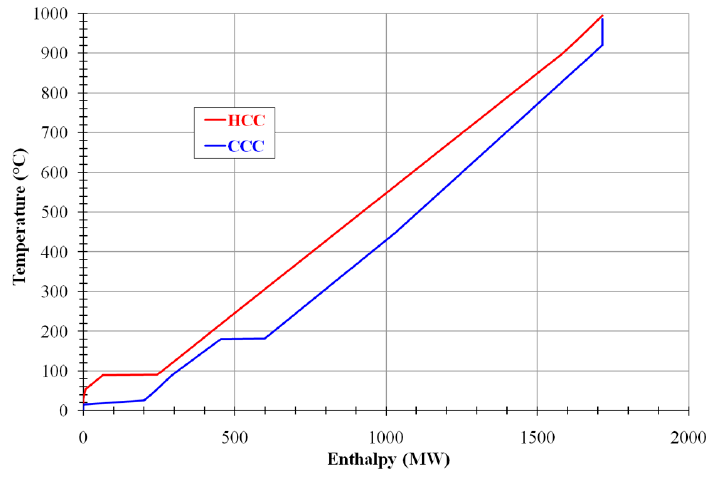
Figure 4. Hot and cold composite curves for CLAS system used in conjunction with Case 1c.